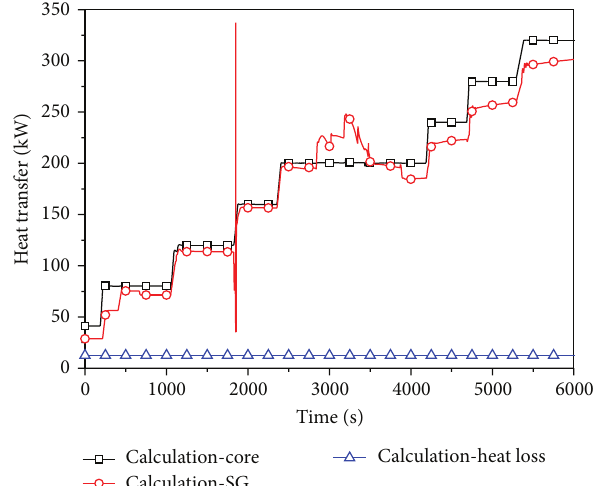
Figure 8: Primary mass flow rate with different press loss model.